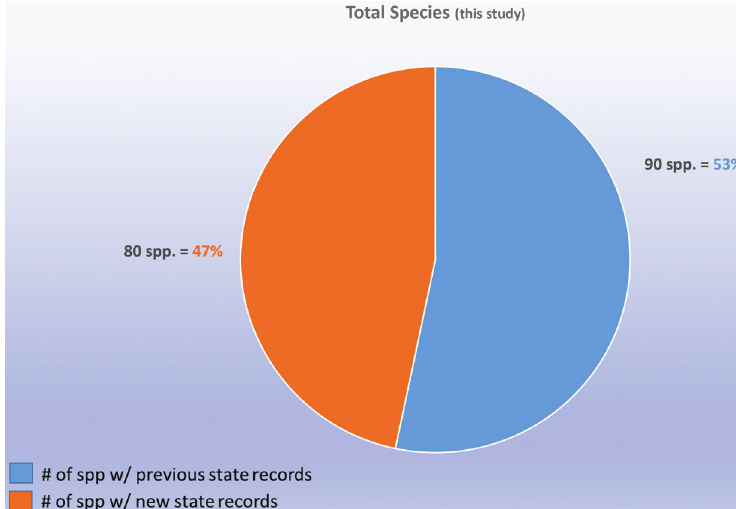
Figure 10. Summary of all new records for selected genera.